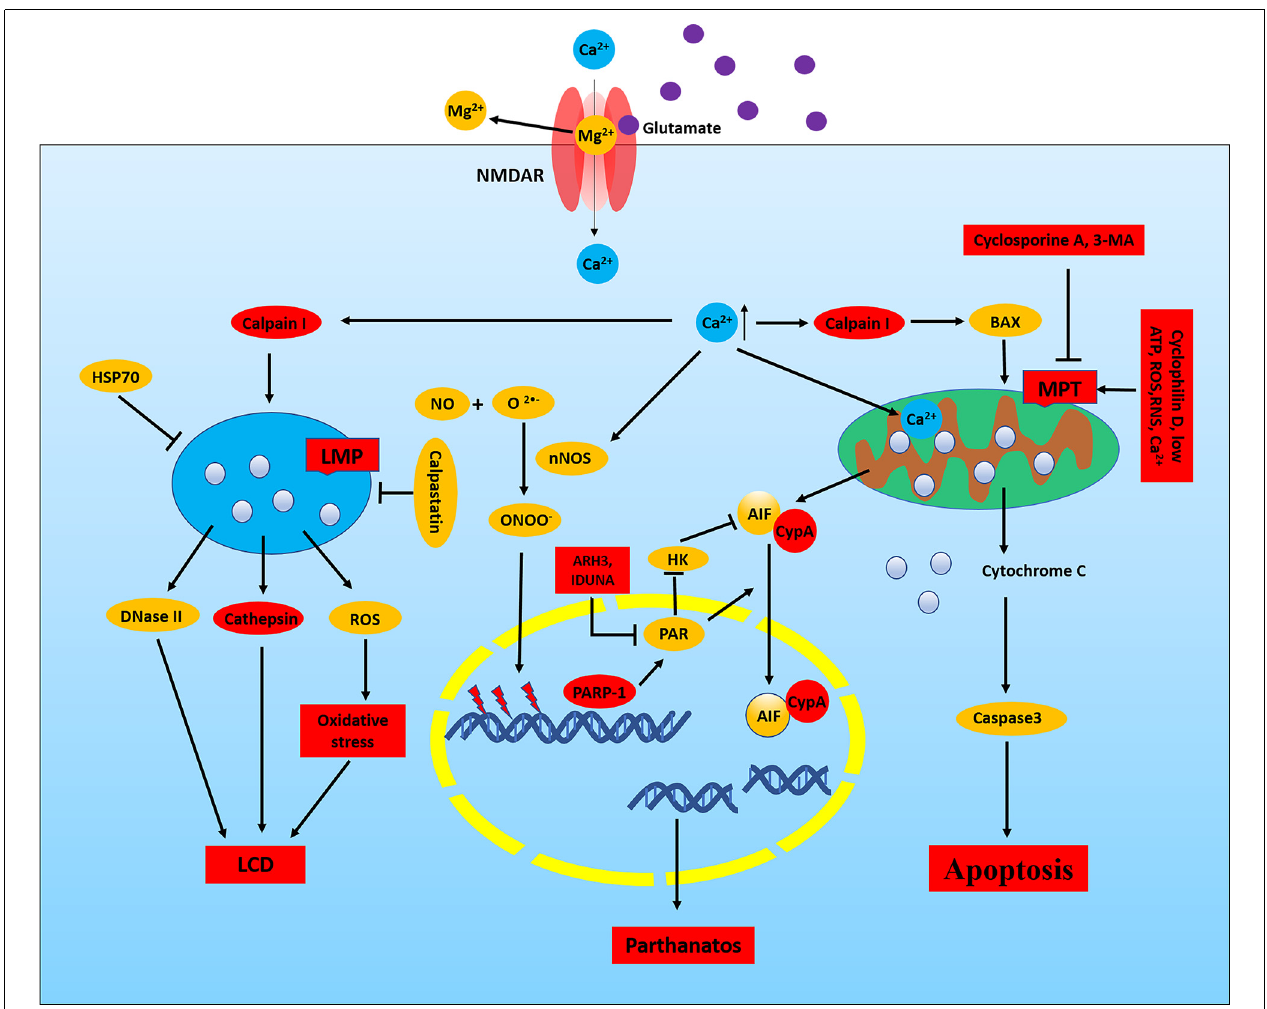
FIGURE 2 | NMDAR-mediated excitotoxicity in epilepsy. In neurons, the NMDAR channel is blocked by Mg 2+ at neuronal resting membrane potential, and Mg 2+ is removed when the membrane is depolarized. Activated NMDAR leads to calcium loading which will cause the activation of nNOS, calpain I, and